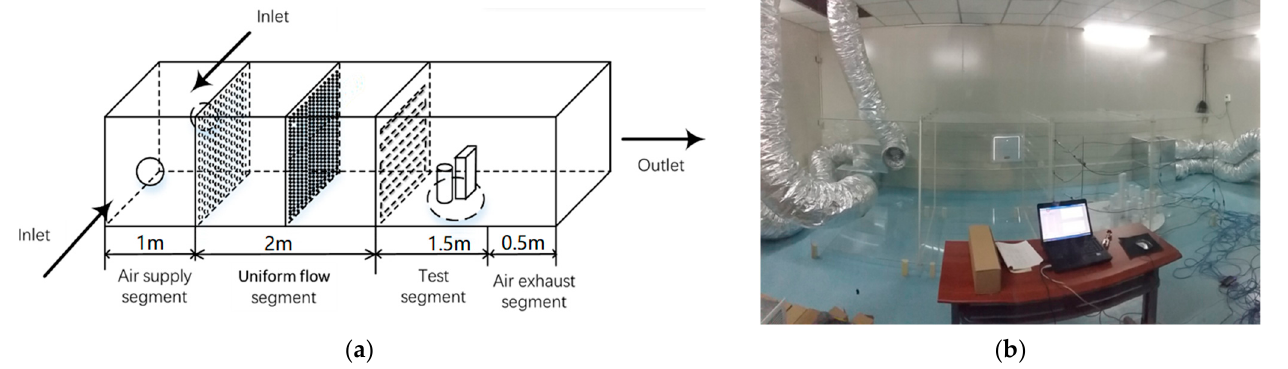
Figure 2. The wind tunnel platform. ( a ) Diagram of the platform; ( b ) Picture of the platform.